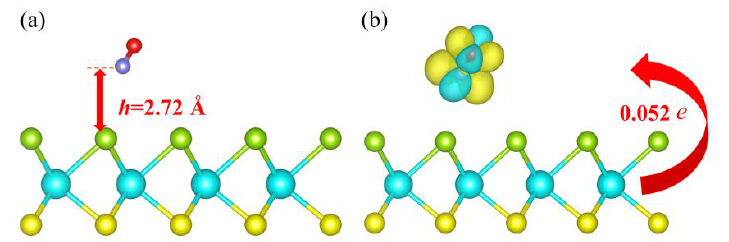
Figure 2. The optimized structure in a side view ( a ) and CDD image ( b ) for adsorption system, composed of pristine Janus WSSe monolayer and NO gas molecule. The h in red represents the adsorption distance from NO to pristine Janus WSSe monolayer. Charge deposition (exhaustion) is indicated by yellow (cyan) areas. The value of the isosurface is 0.002 e Å −3 , and that red arrow indicates the charge transfer direction.